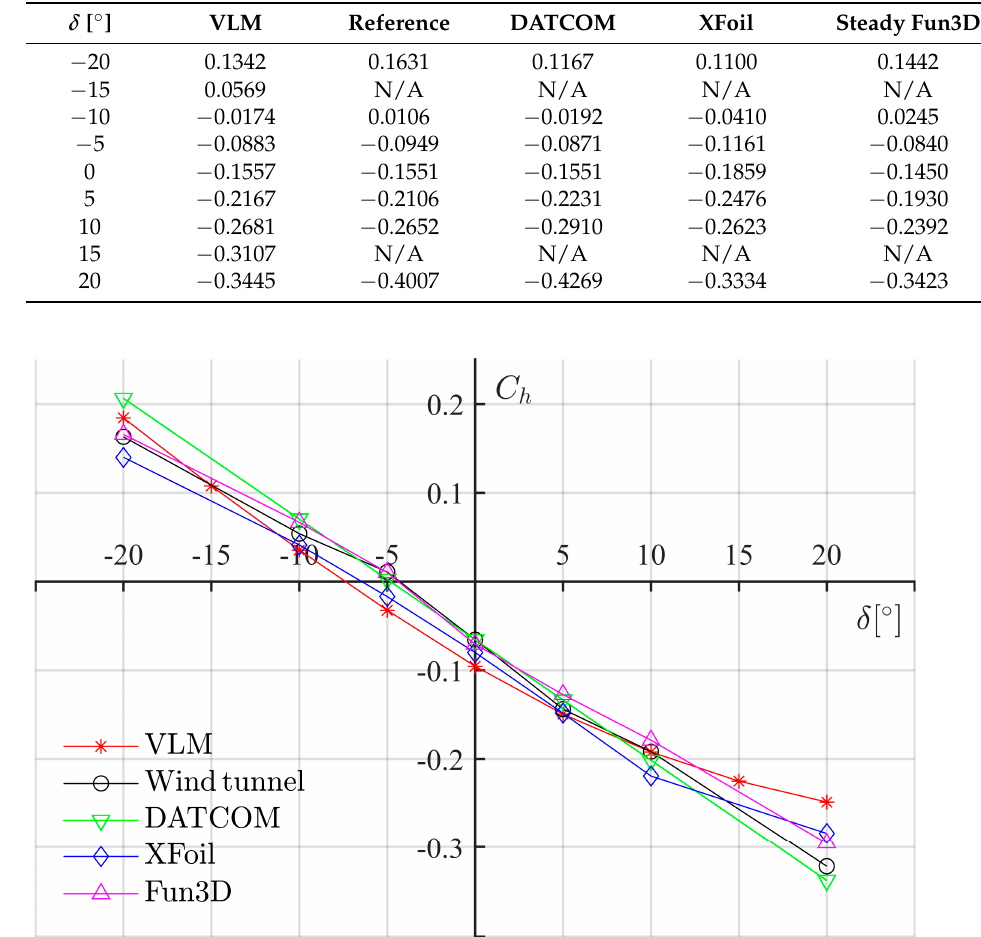
C versus δ for GA(W) − 1 at alpha − 8°. Figure A7. C h versus δ for GA(W) − 1 at alpha − 8 ◦ h C for GA(W) − 1 at alpha − 8°. h